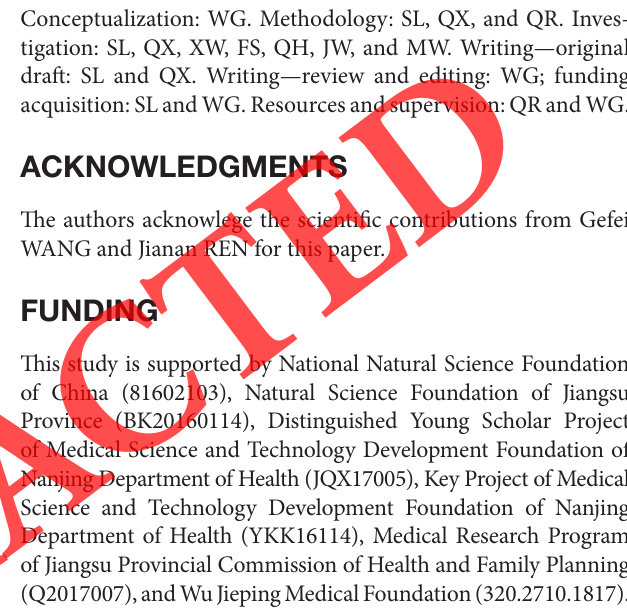
FigUre 5 | Stimulator of interferon genes controls Th17 responses for host defense against Salmonella infection. (a) Survival curves of C57BL/6 and Tmem173 − / − mice infected with Salmonella . Mice were inoculated orally with Salmonella and observed for 7 days after infection ( n = 8). Statistical significance ( p = 0.01) was determined by log-rank test. (B) Flow cytometry analysis of cDCs (top) and IL-17A-expressing CD4 + T cells (bottom) in small intestine lamina propria (SILP) during Salmonella infection. C57BL/6, Tmem173 − / − , and Il17a GFP/GFP reporter mice were inoculated orally with Salmonella 24 h before sacrifice. Representative of three independent experiments ( n = 4). (c) IL-17A production during antigen-specific T cell activation by cDCs or pDCs isolated from either uninfected (Contl.) or Salmonella- infected (Sal.) C57BL/6 mice. DCs were isolated from SILP and were cocultured with splenic CD4 + CD62L + CD44 − naïve T cells from OT-II transgenic mice in the presence of OVA for 3 days in vitro . Representative of three independent experiments ( n = 4). (D) Fold change of Il6 , Il1b , Tnf , Ifnb1 , Il10 , Il23a , and Tgfb1 gene expression in cDCs as well as IL-17A, IFN- γ , and IL-4 production by CD4 + T cells after Salmonella infection. C57BL/6 and Tmem173 − / − mice were infected with Salmonella as described in panel (B) . cDCs and CD4 + T cells were isolated from SILP. CD4 + T cells were then stimulated in vitro by anti-CD3 and anti-CD28 for 3 days ( n = 5). (e) Bacterial load in liver after Salmonella infection ( n = 3). C57BL/6 and Tmem173 − / − mice were infected with Salmonella as described in panel (B) . Abbreviations: ND, not detectable; pDC, plasmacytoid DC; cDC, classical dendritic cell.